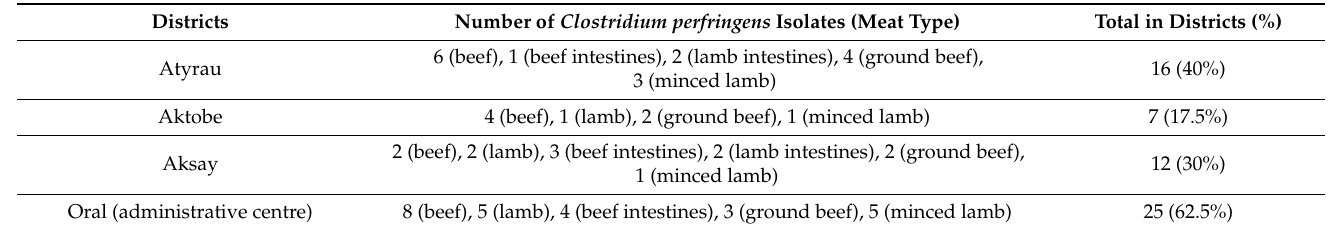
Table 2. Prevalence of C. perfringens isolates in meat samples ( n = 240) taken from meat fairs ( n = 4) in West